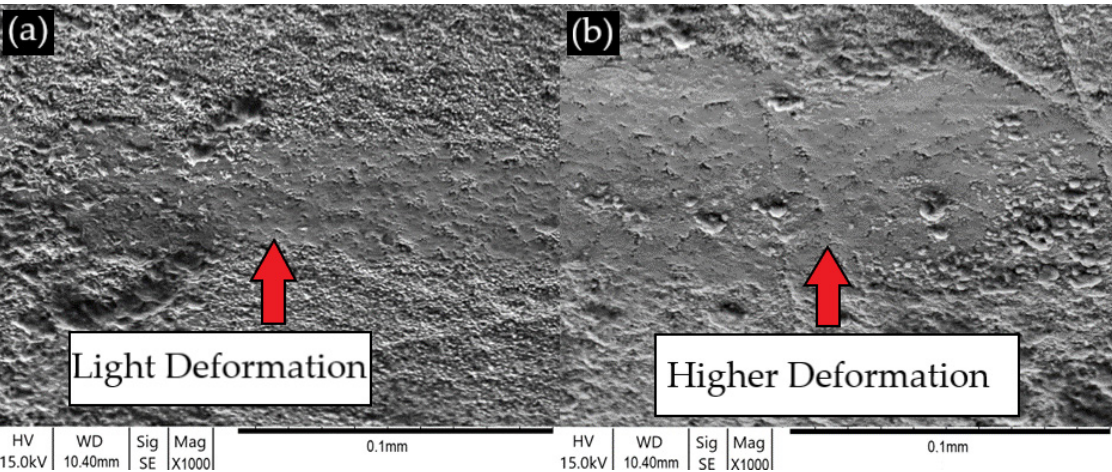
Figure 23. ( a ) Coating B scratch position 1 and ( b ) Coating B scratch position 3 at ×1000 magnifica- tion.